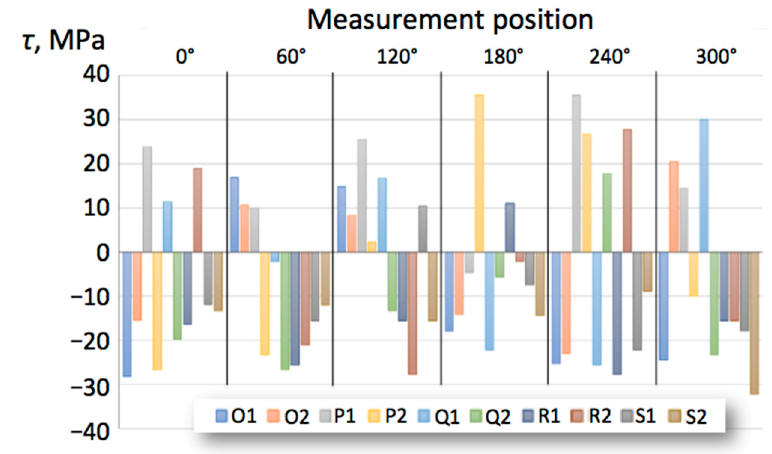
Figure 12. Results of shear stress τ measurement.